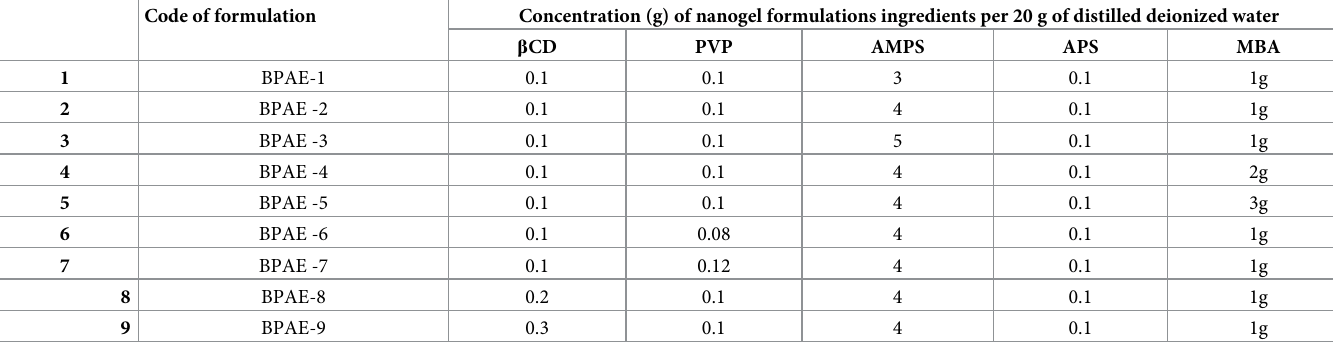
Table 1. Composition of β CD/PVP-co-poly (AMPS) nanogels. Code of